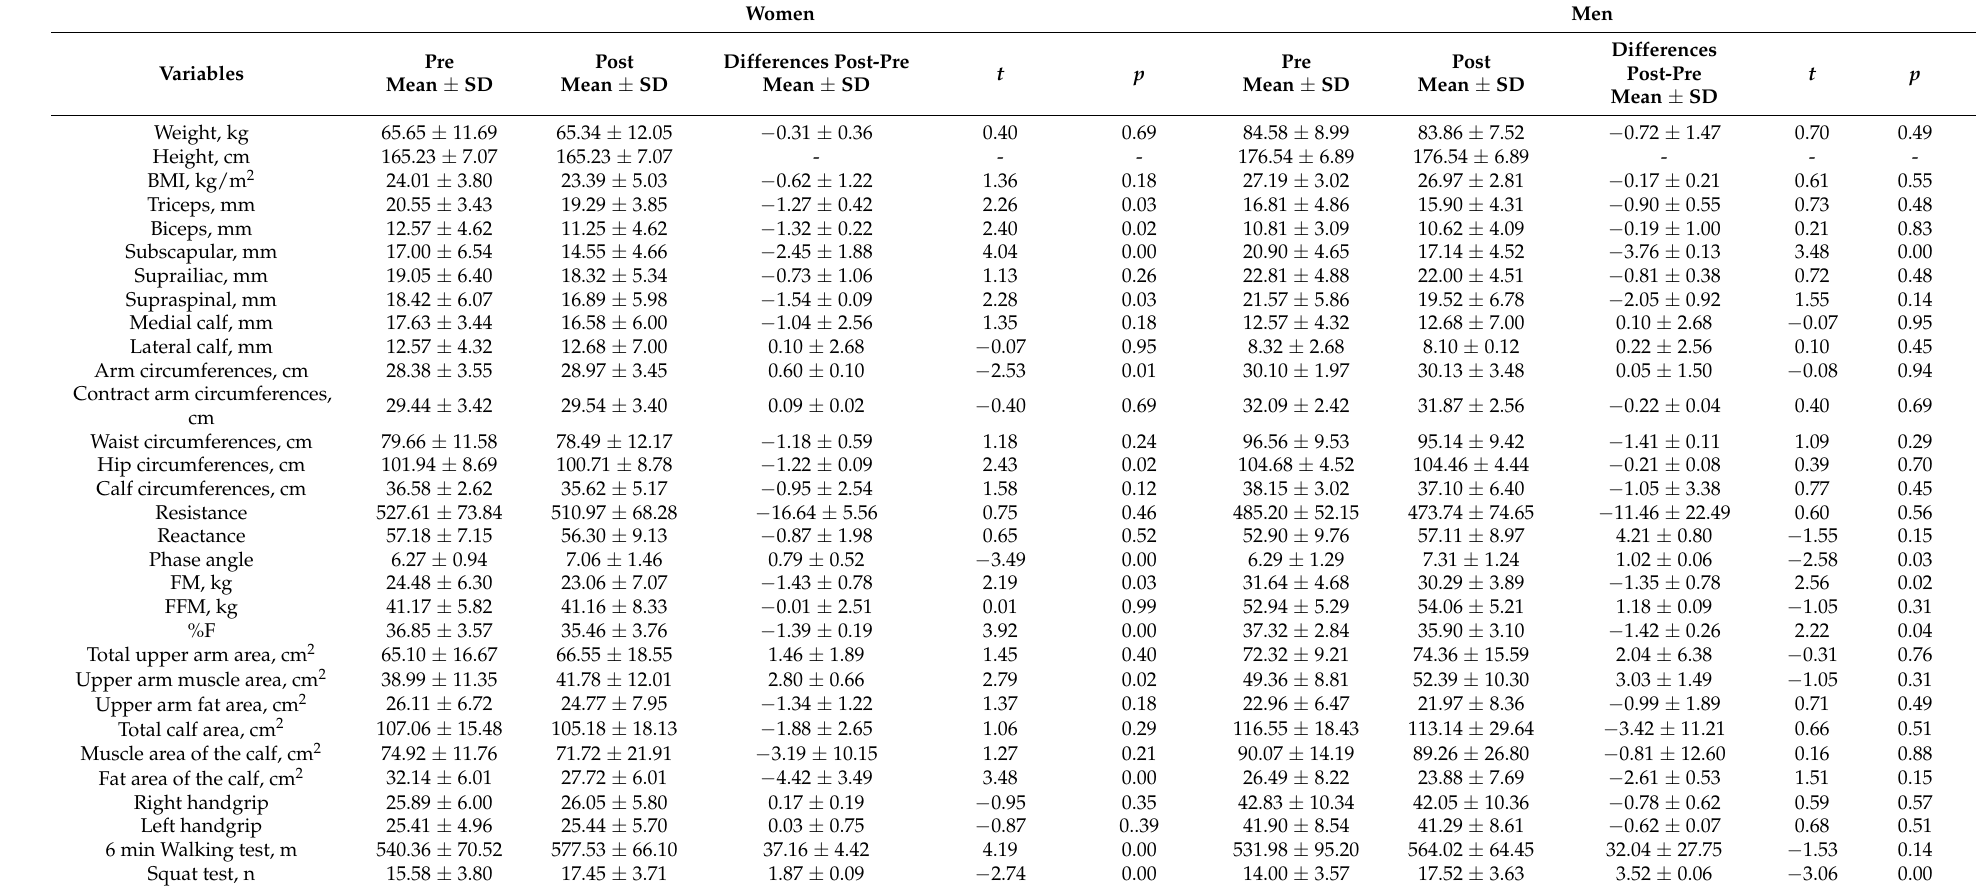
Table 2. Paired Students’ test and participants’ anthropometric measures, body composition and physical test values. Women